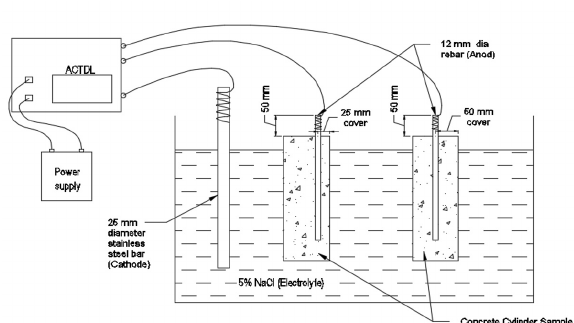
Fig. 2. Schematic diagram of Accelerated Corrosion